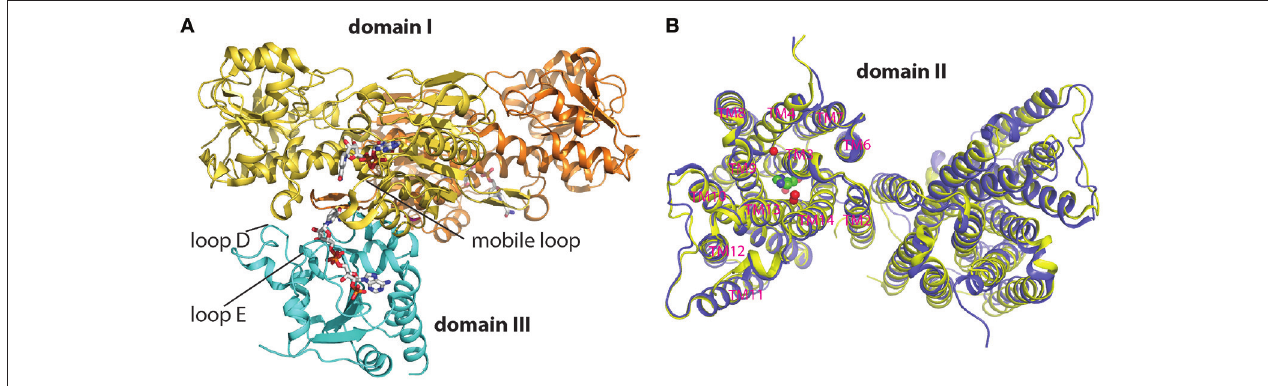
FIGURE 2 | Reaction catalysis and proton-translocating sites in TH. (A) Hydride transfer between the proximate NAD(H) and NADP(H) binding sites of domains I and III. Shown is a nucleotide-bound (sticks), trimeric (domain I) 2 :(domain III) structure of TH from T. thermophilus (PDB: 4J16), with the NADP(H) binding site in domain III (cyan) facing up. Flexible loops involved in ligand binding are indicated. (B) Proton translocation in domain II. Domain II dimerization (from T. thermophilus ) is mediated by TM2-TM2 interaction. Displacement of the second subunit is observed by the alignment of the two structures (PDB: 5UNI, blue; 4O93, yellow) solved under different pH conditions. Crystallographically solved water molecules (red balls) and the channel gating histidine residue (His42 α 2 on TM3, green sphere) are shown inside the proton channel within one subunit of 5UNI. Structures shown represent a view from the cytoplasmic side.